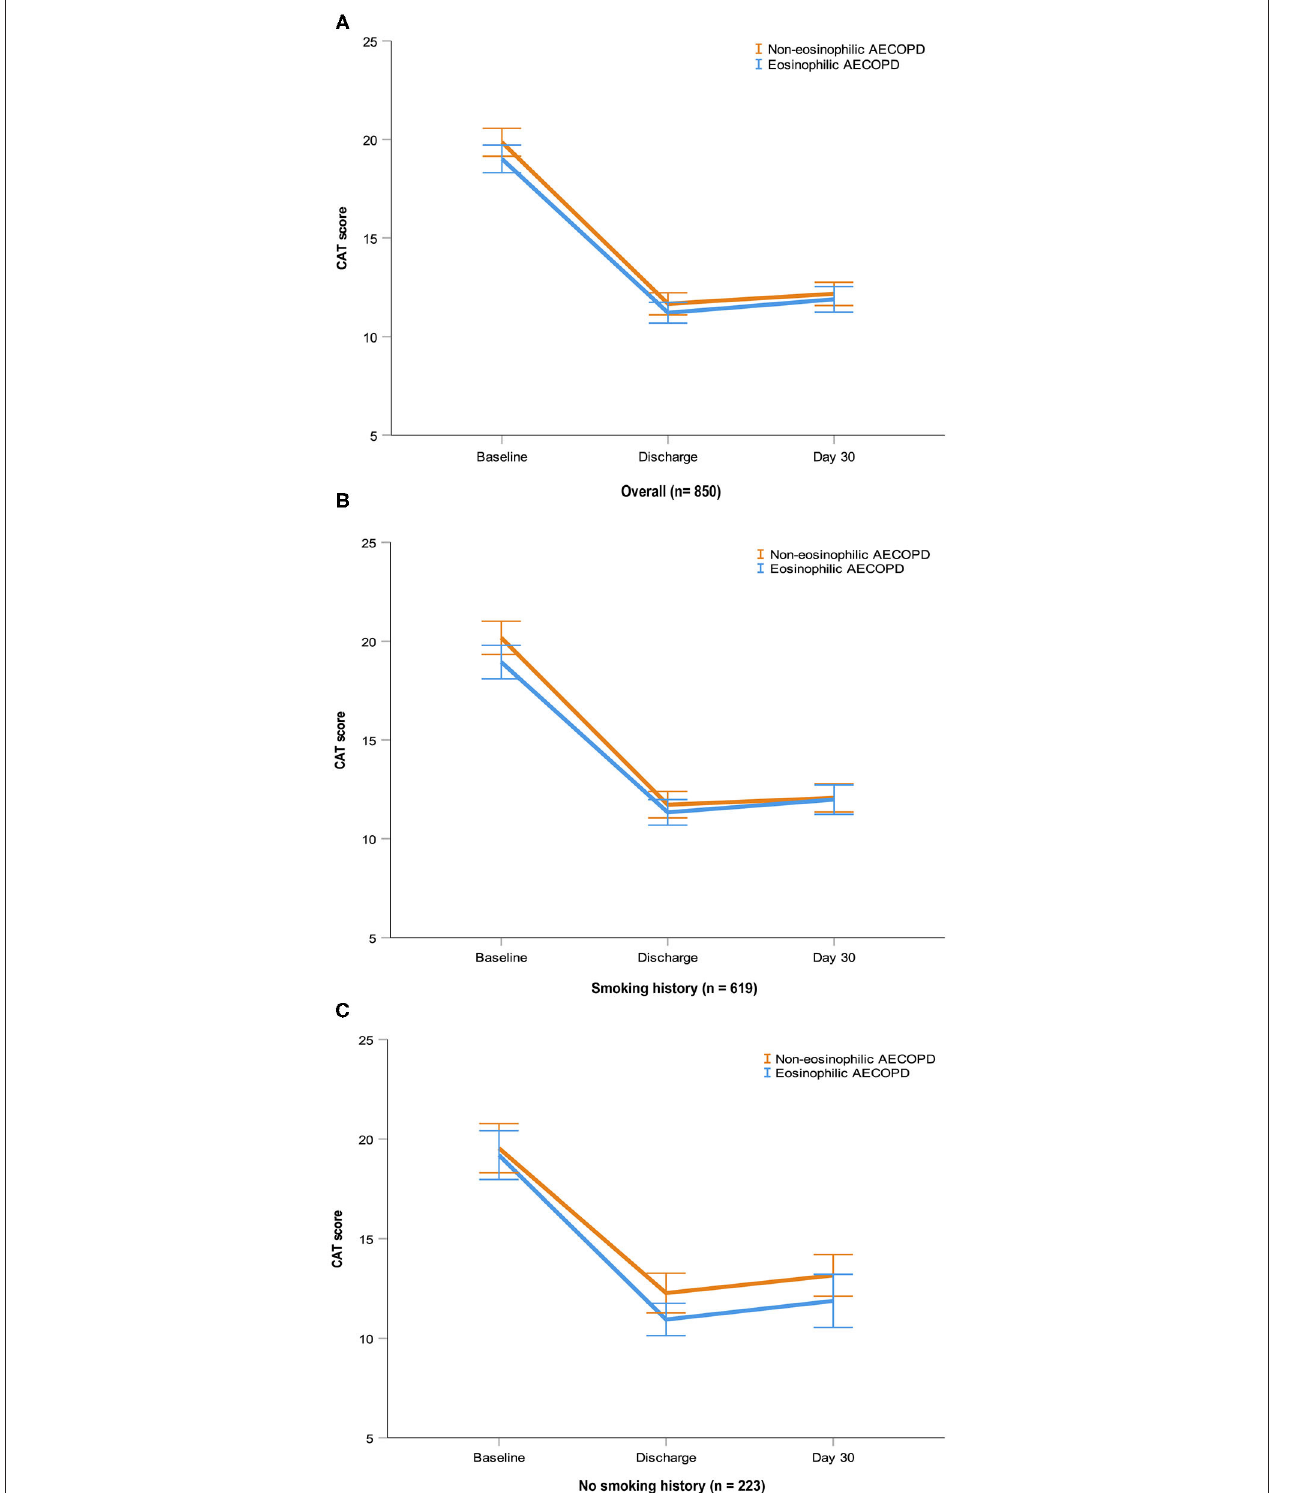
FIGURE 5 | CAT scores at baseline, discharge and day 30 in the three matched cohorts. Data are presented as mean (SEM). AECOPD, acute exacerbations of chronic obstructive pulmonary disease; CAT, COPD Assessment Test; SEM, standard error of mean.